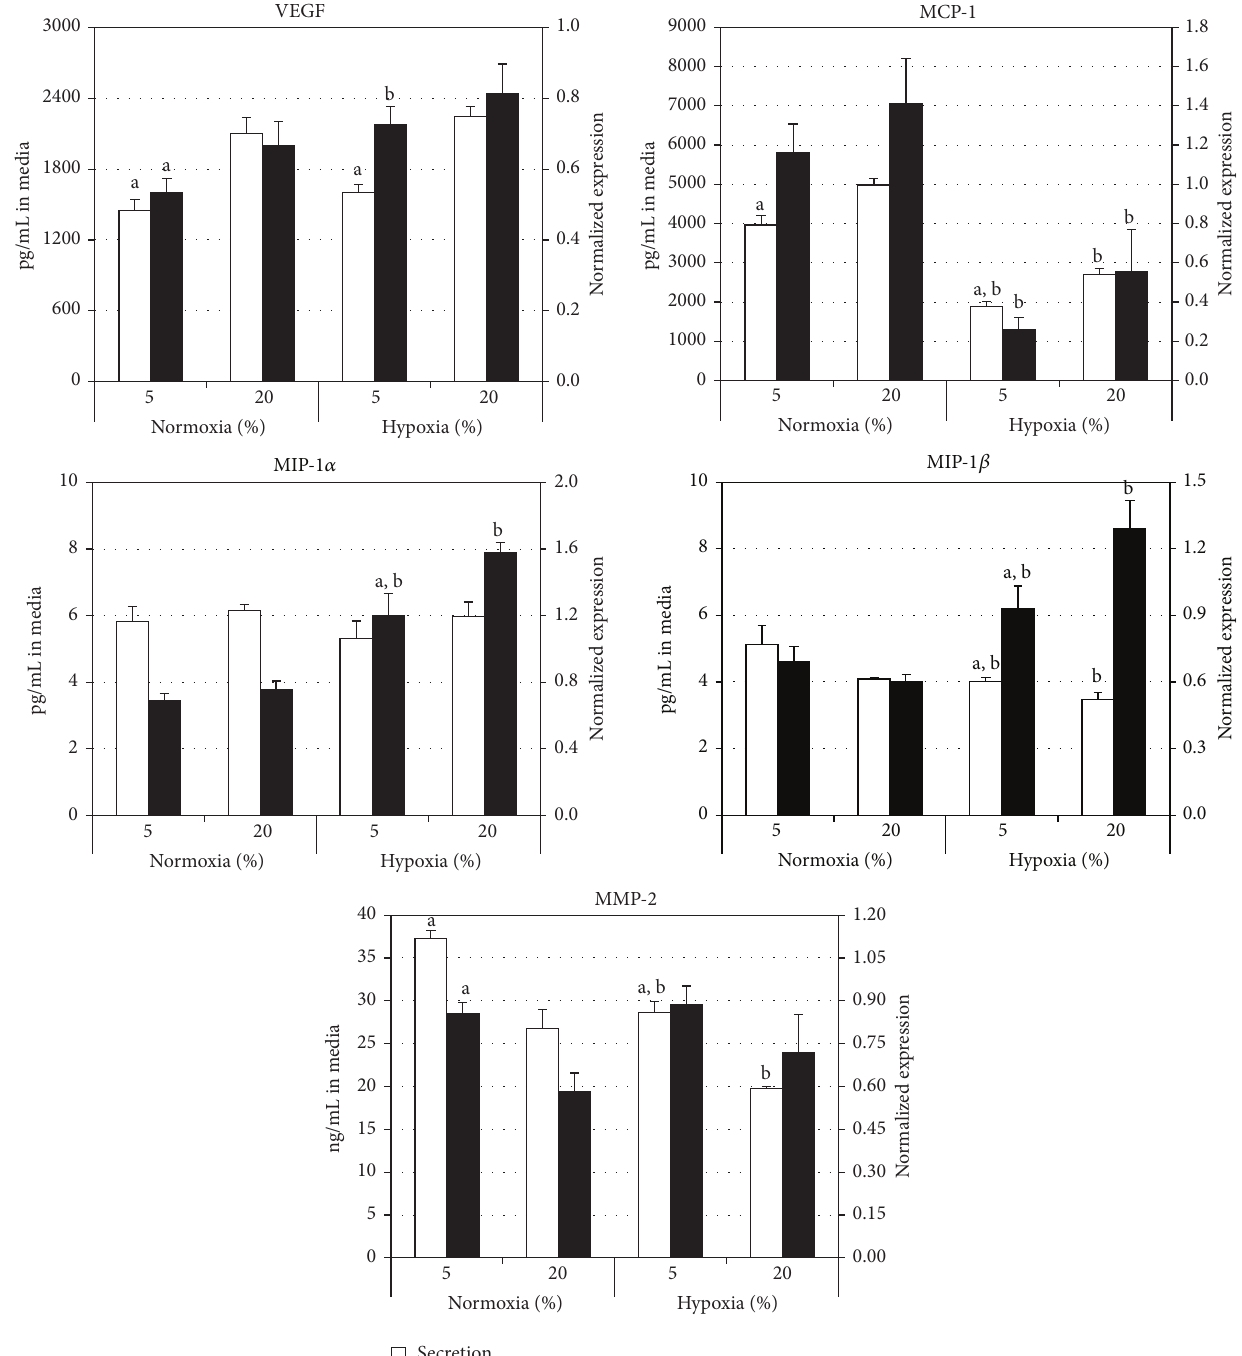
Figure 1: Normalized relative expression and secretion of paracrine factors under different oxygen and serum conditions. Data reported as mean ± SE. 5% and 20% refer to the amount of serum supplement present in the media. Open bars: secretion of factors into media. Solid bars: relative mRNA expression. (a) 𝑃 < 0.05 versus 20%, (b) 𝑃 < 0.05 versus normoxia.